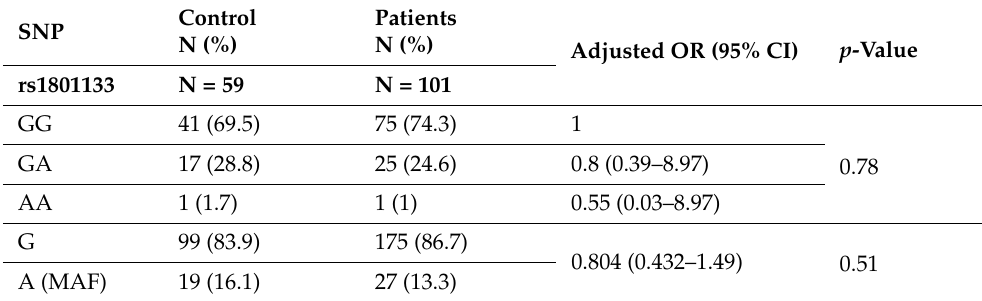
Figure 2. Allelic discrimination plot for rs1801133 from random samples: ( A ) control samples; ( B ) patient samples. Table 3. Genotype distributions of MTHFR and allele frequencies among all